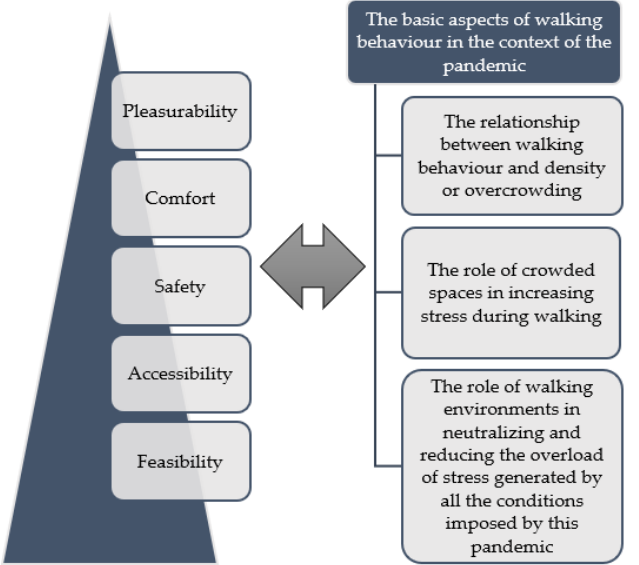
Figure 1. Interrelationship between different aspects of walking in the context of the pandemic and different levels of the hierarchy of walking needs.